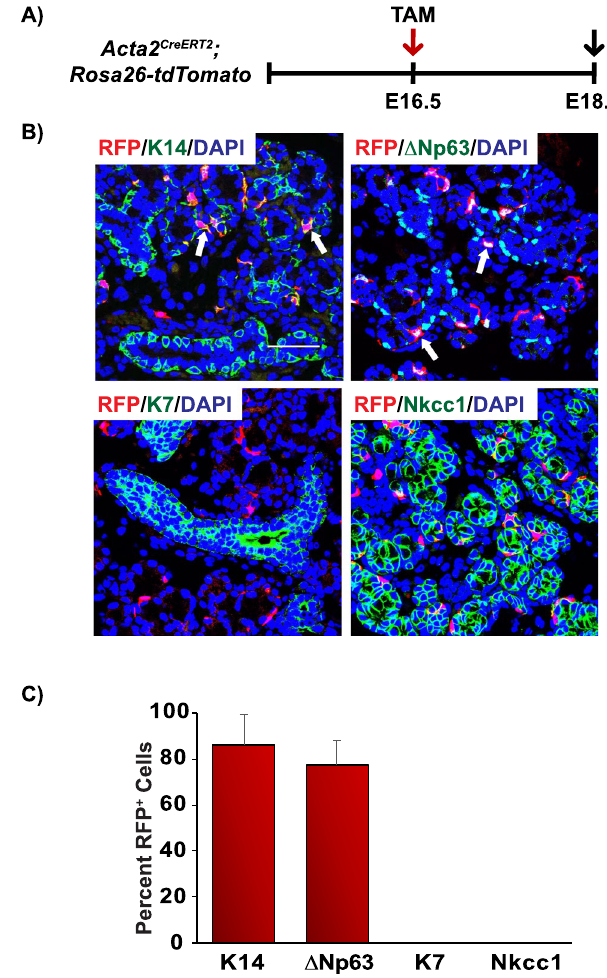
Figure 5. Contribution of SMA + cells during salivary gland development. ( A ) Schematic depicting the experimental timeline for the genetic lineage tracing studies performed in the Acta2 CreERT2 ;Rosa26-tdTomato mice. ( B ) SMA + cells contribute exclusively to the basal and myoepithelial cell lineages. ( C ) Quantification of the percentage of RFP + cells which co-express the various cell lineage markers as indicated. Data are represented as mean ± standard deviation (S.D.). Arrows highlight double positive cells as indicated. Scale bar 37 μ m. TAM- tamoxifen, E-embryonic. n = 4